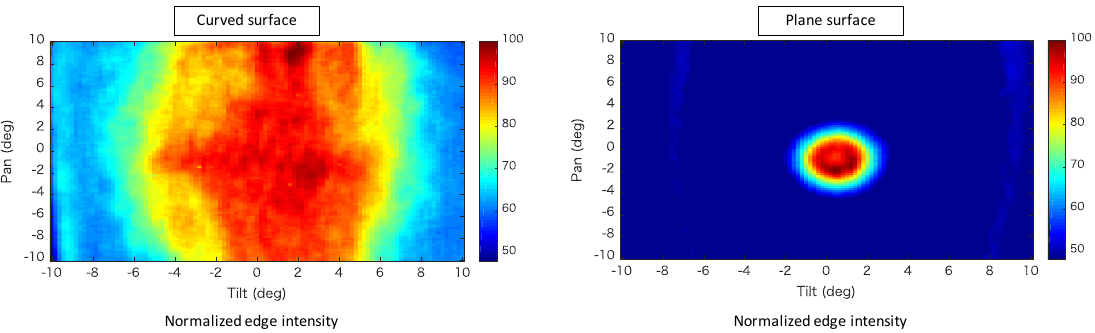
Figure 9. Colormap of the average normalized edge intensity values with respect to the pan- and tilt-axis mirror